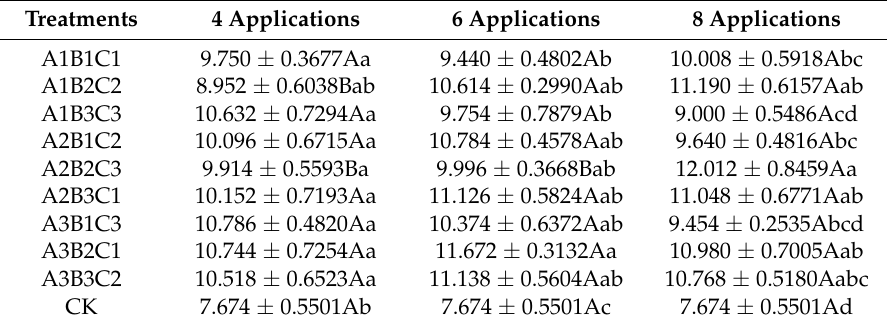
Table 5. Effects of different fertilization ratios and frequencies on root collar